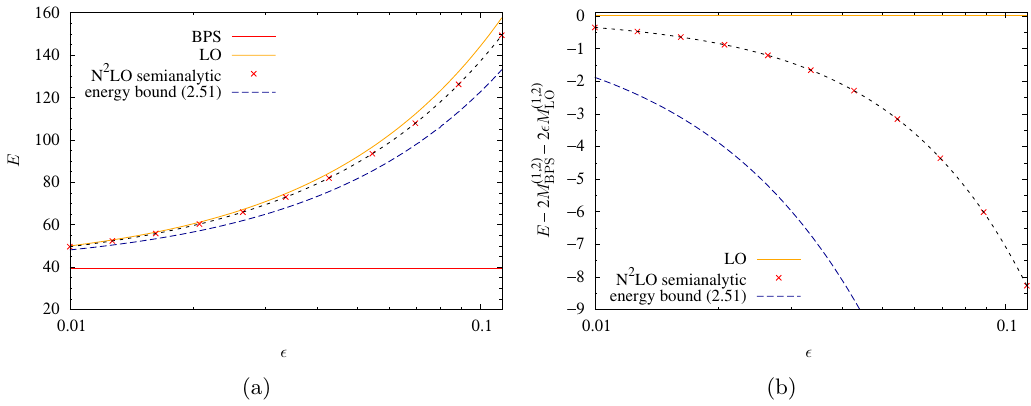
Figure 9 . The (a) energy and (b) N 2 LO correction to the energy for two B = 1 Skyrmions with separation distance 2 a = 0 (they touch in one point) as a function of (cid:15) . The BPS energy is shown with a red solid line, the LO correction is shown with an orange solid line and the numerically computed N 2 LO corrections are shown with red crosses (linked with black dashed lines for ease of reading the figure). The energy bound (A.8) is shown with a blue-dashed line. In this figure c 2 = 1 , c 4 = 8 , c 6 = 1 , µ = 1 , m π = 3 , R = (3 π ) 1 3 and ( s, p ) = (1 , 2) . 2